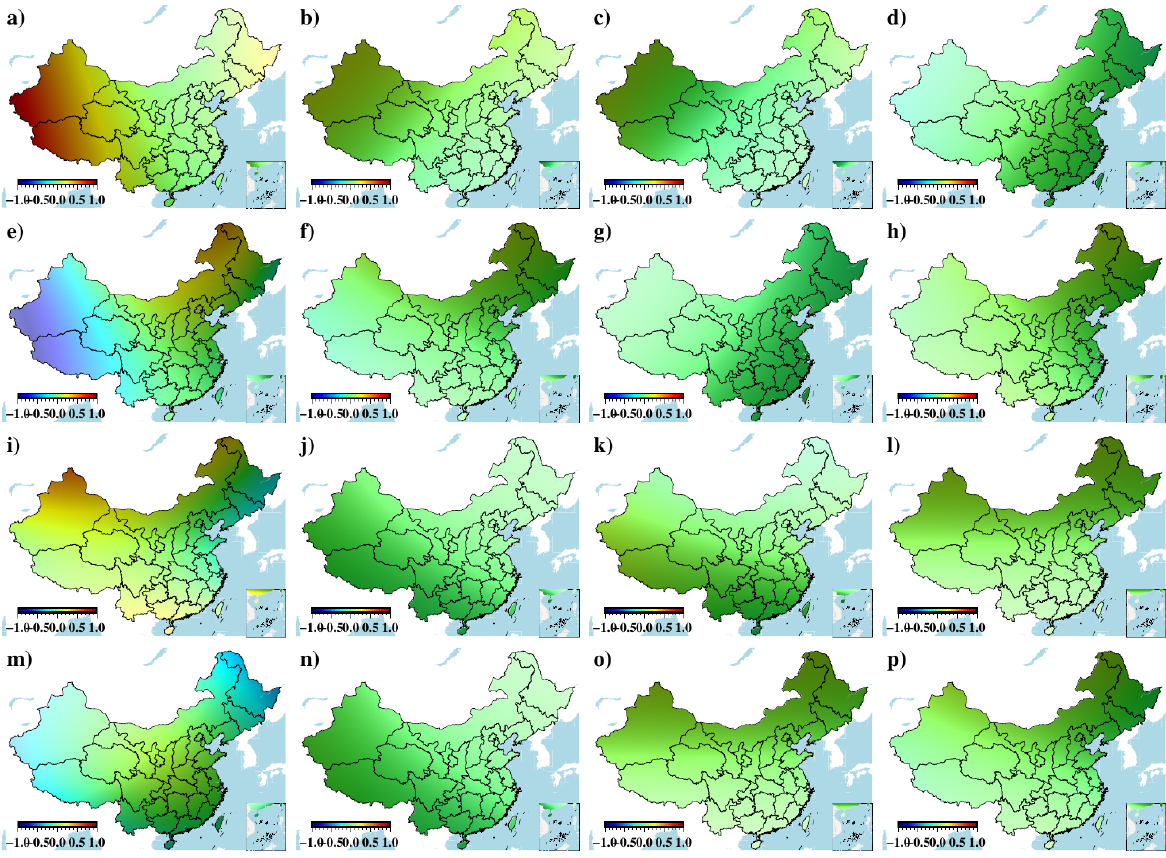
Figure 8. The spatial offset model of the experimental cities. The first row refers to January, the second row to March, the third row to June, and the fourth row to September. The columns from left to right refer to the bands Green, Red, NIR and